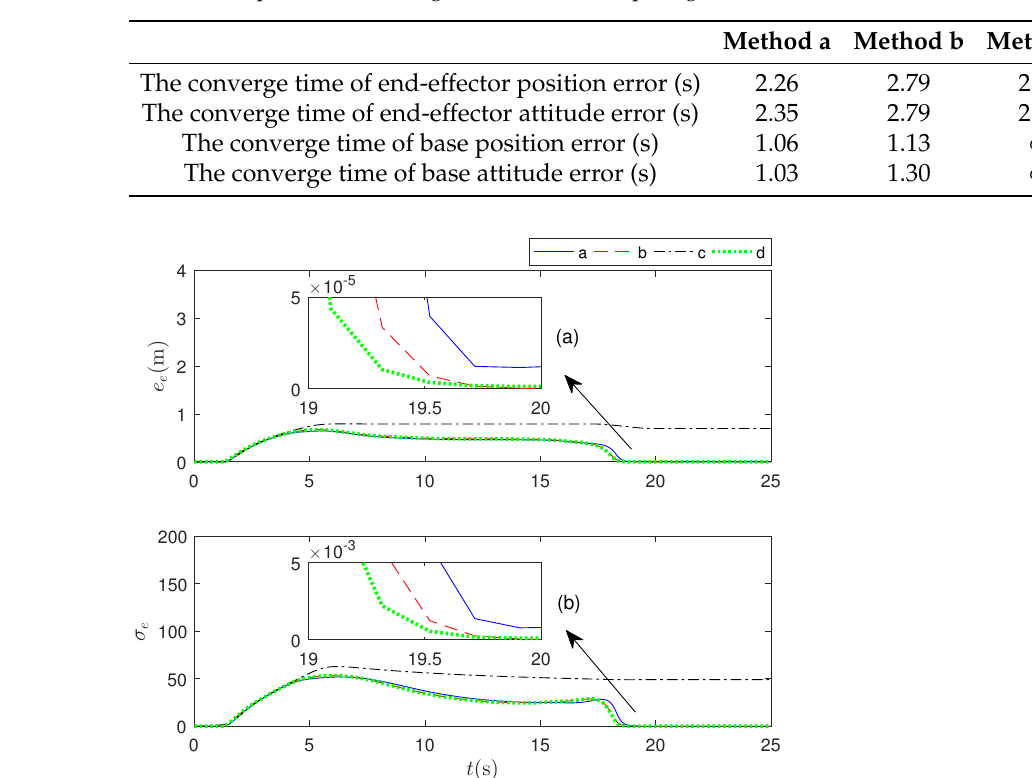
Table 5. The pose error converge time of three comparing methods.